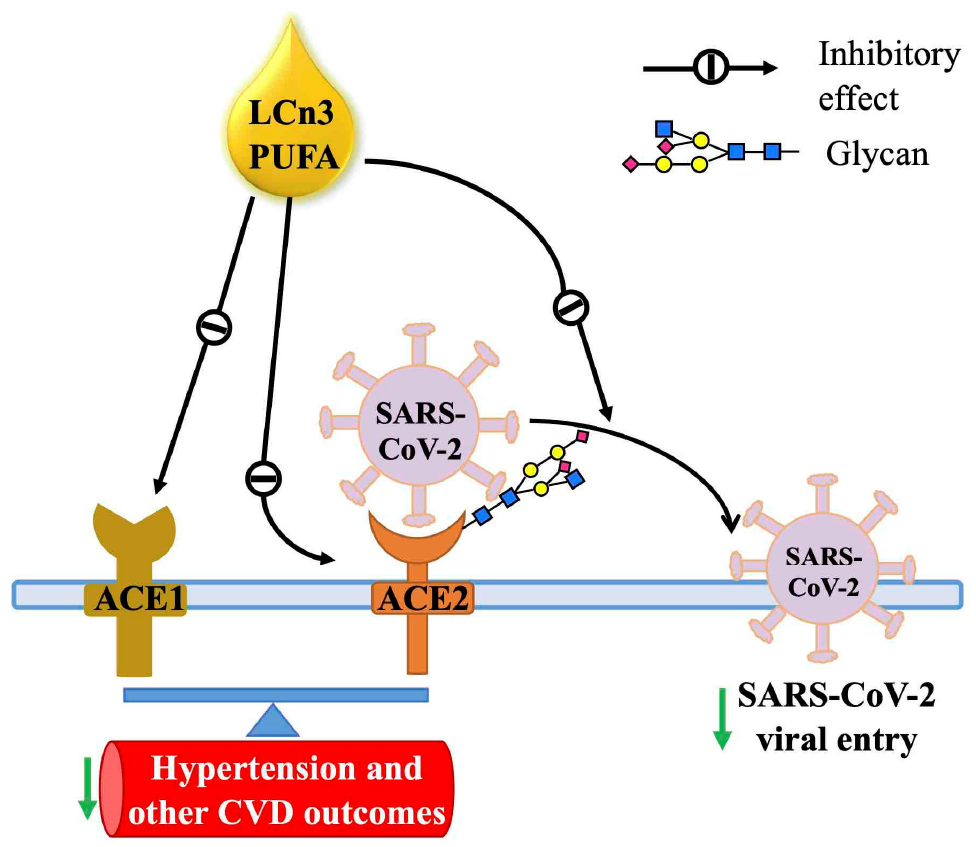
Figure 5. Schematic of proposed mechanism of action. LCn3-PUFAs, EPA and DHA, reduce ACE2 protein levels. These n3-PUFAs may also decrease ACE2 glycosylation. These mechanisms may explain how DHA blocks SARS-CoV-2 pseudovirus entry into HEK293 cells. LCn3-PUFAs also downregulate ACE1 protein levels, thus maintaining the balance between ACE1 and ACE2, and diminishing the risk of adverse CVD outcomes. This figure was prepared by S. Huang using Microsoft PowerPoint software version 16.16.27.